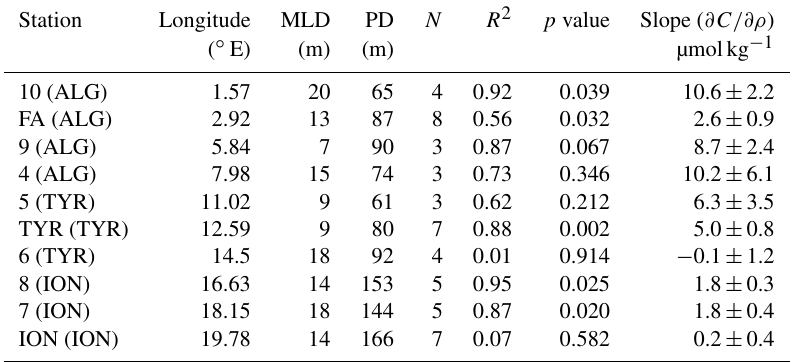
Table 3. Results of the linear fitting computed for each station between phosphate concentration and density at the phosphate-depleted layer (between the surface and the phosphacline). The slope of the regression line corresponds to the gradient in phosphate concentration over density inside the